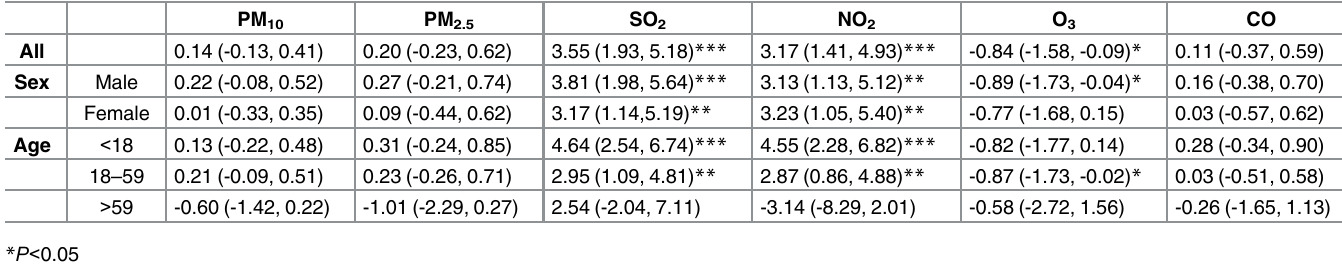
Table 3. Percent change (mean and 95% confidence interval) in daily outpatient-visits for epilepsy associated with a 10 μ g/m 3 (PM 10 , PM 2.5 , SO 2 , NO 2 , and O 3 ) or 0.1 mg/m 3 (CO) increase of air pollutants on the concurrent days in single-pollutant models.